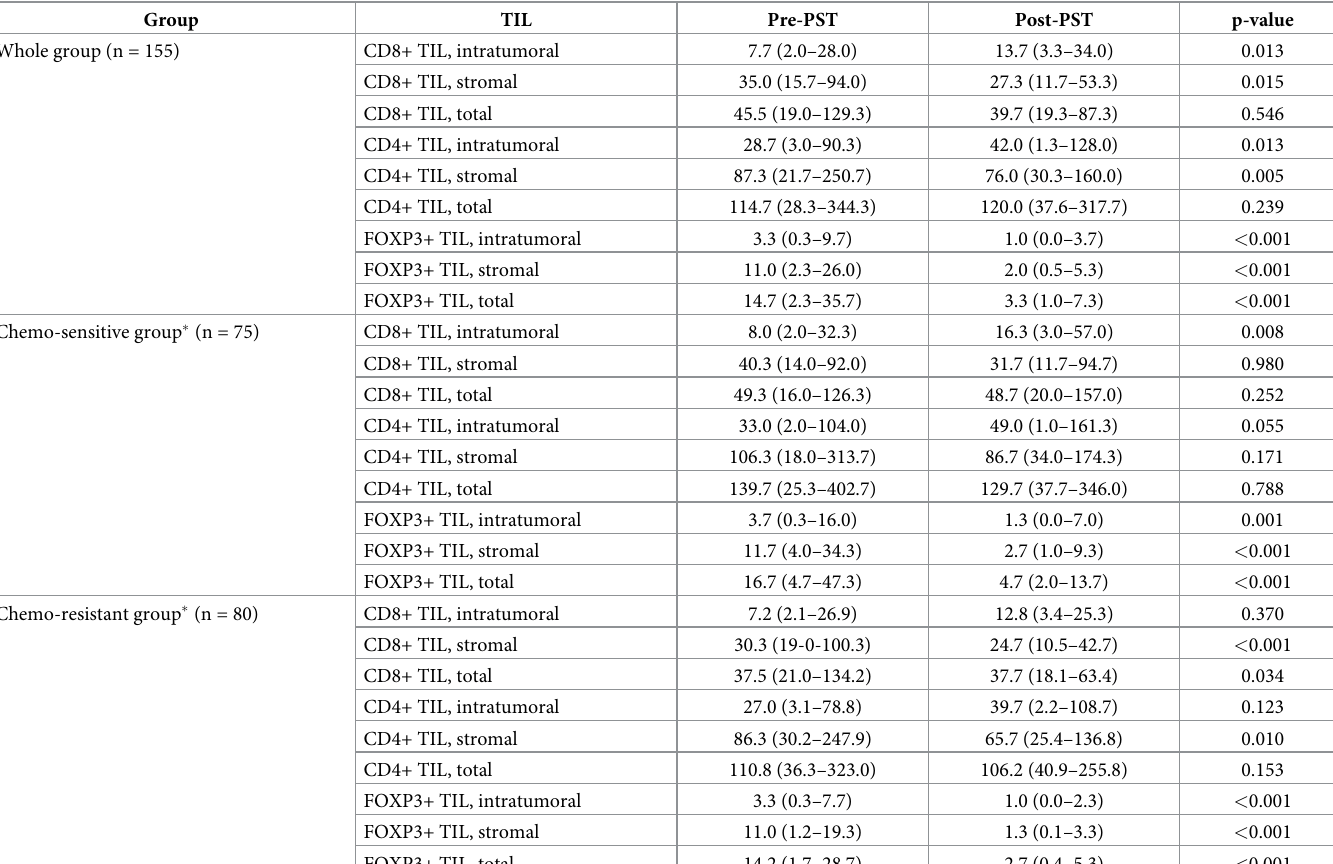
Table 2. Paired analyses of tumor-infiltrating lymphocytes before and after primary systemic therapy.